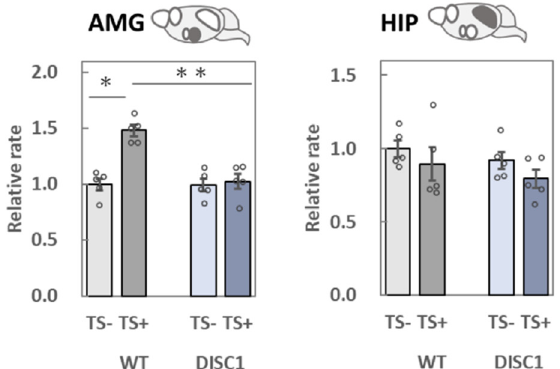
Figure 4. Measurement of polySia levels by ELISA (735 antibody). PolySia expression levels in the five brain regions collected from the four groups of mice were analyzed. The samples were added to the wells of a 96-well plate (250 ng as protein), and the amounts of polySia were determined using the 735 anti-polySia antibody. The same sample was treated with endo-N, and subtraction was performed for specific polySia measurements. All data points represent averages of the three assays. The average in group 1 [WT, TS-] was set to 1. Error bars indicate the SEM ( n = 5). OB: olfactory bulb, PFC: prefrontal cortex, SCN: suprachiasmatic nucleus, AMG: amygdala, HIP: hippocampus. *: p < 0.05, **: p < 0.01.